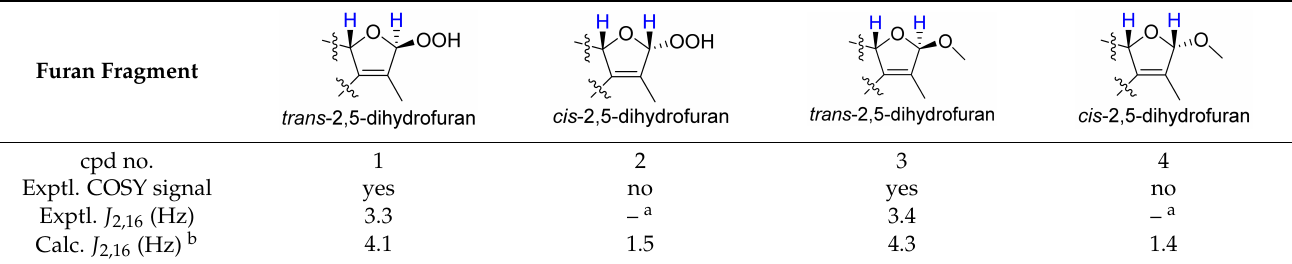
Table 2. The calculated and experimental 4 J H,H coupling constants, as well as experimental COSY correlations between H-2 and H-16 of compounds 1 – 4